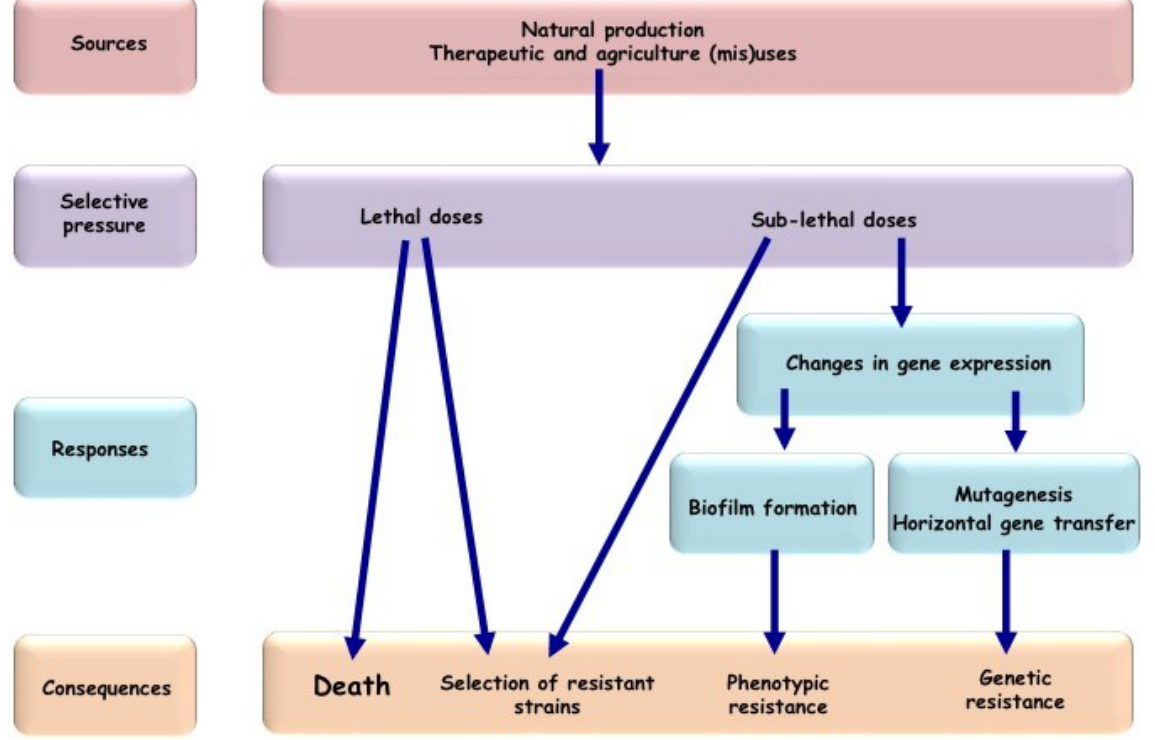
Figure 1. Impact of antibiotics on bacterial